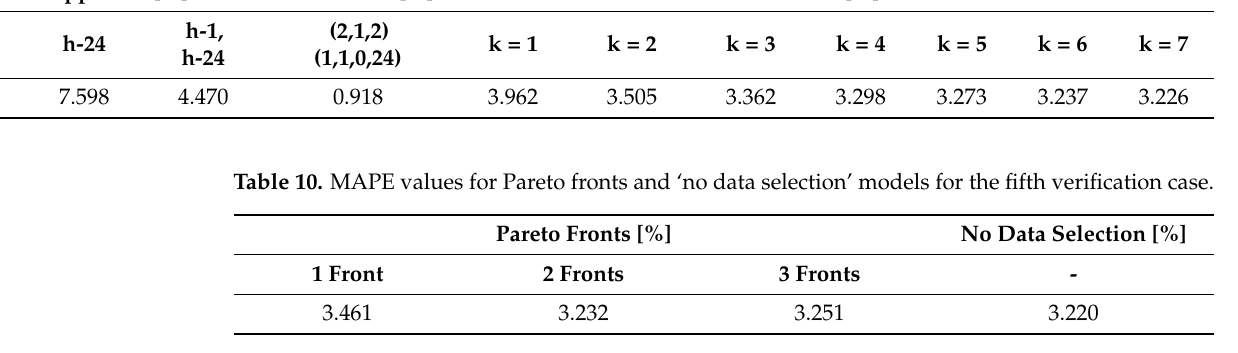
Table 9. MAPE values for naïve approach, SARIMAX model, and kNN algorithm for the fifth verification case. Naïve Approach [%] SARIMAX [%] kNN [%]